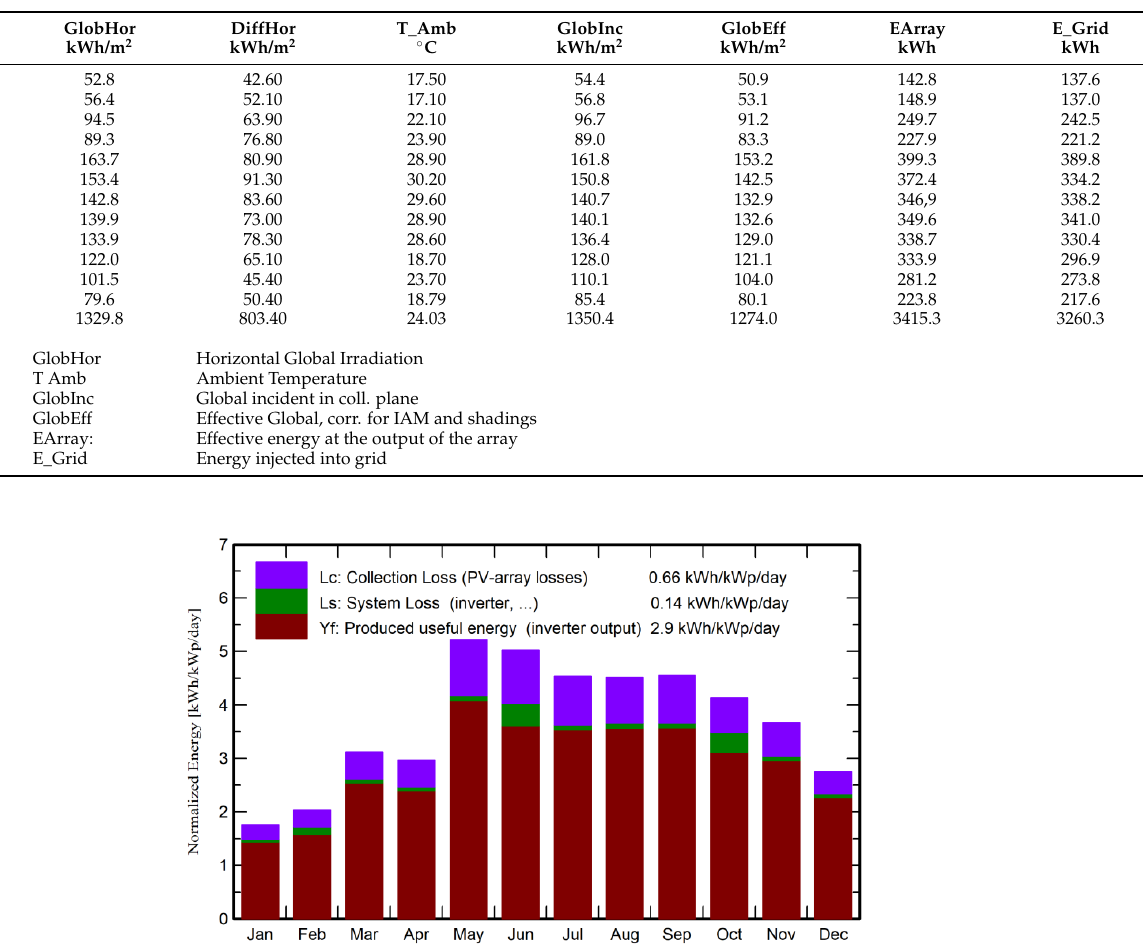
Table 4. The simulation results of the PV system of IES according to weather station data of WB.